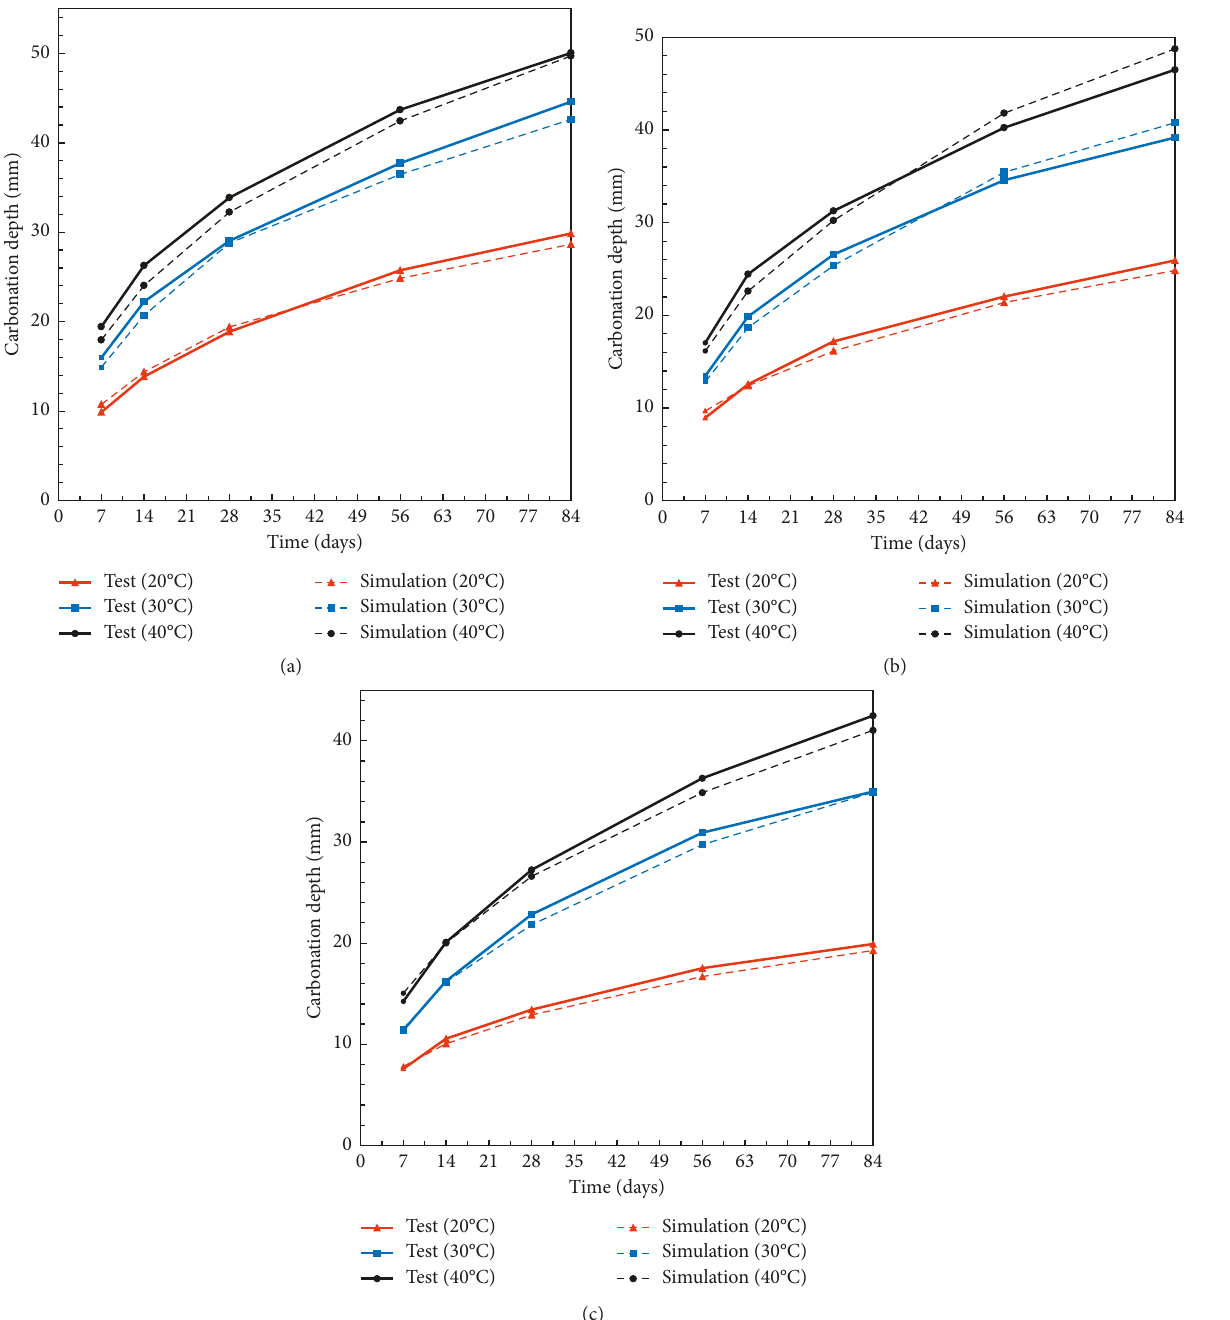
Figure 14: Comparison between test results and simulation results ( X concrete ( X j